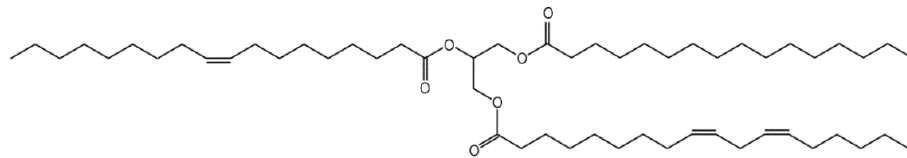
Figure 1. Schematic representation of a triglyceride structure which is the base of vegetable oils, showing different (saturated and unsaturated) fatty acids bonded to a glycerol basic structure through ester bonds.